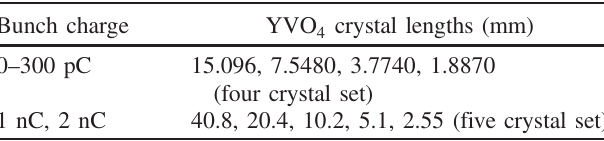
TABLE I. Longitudinal shaping crystal lengths. Bunch charge